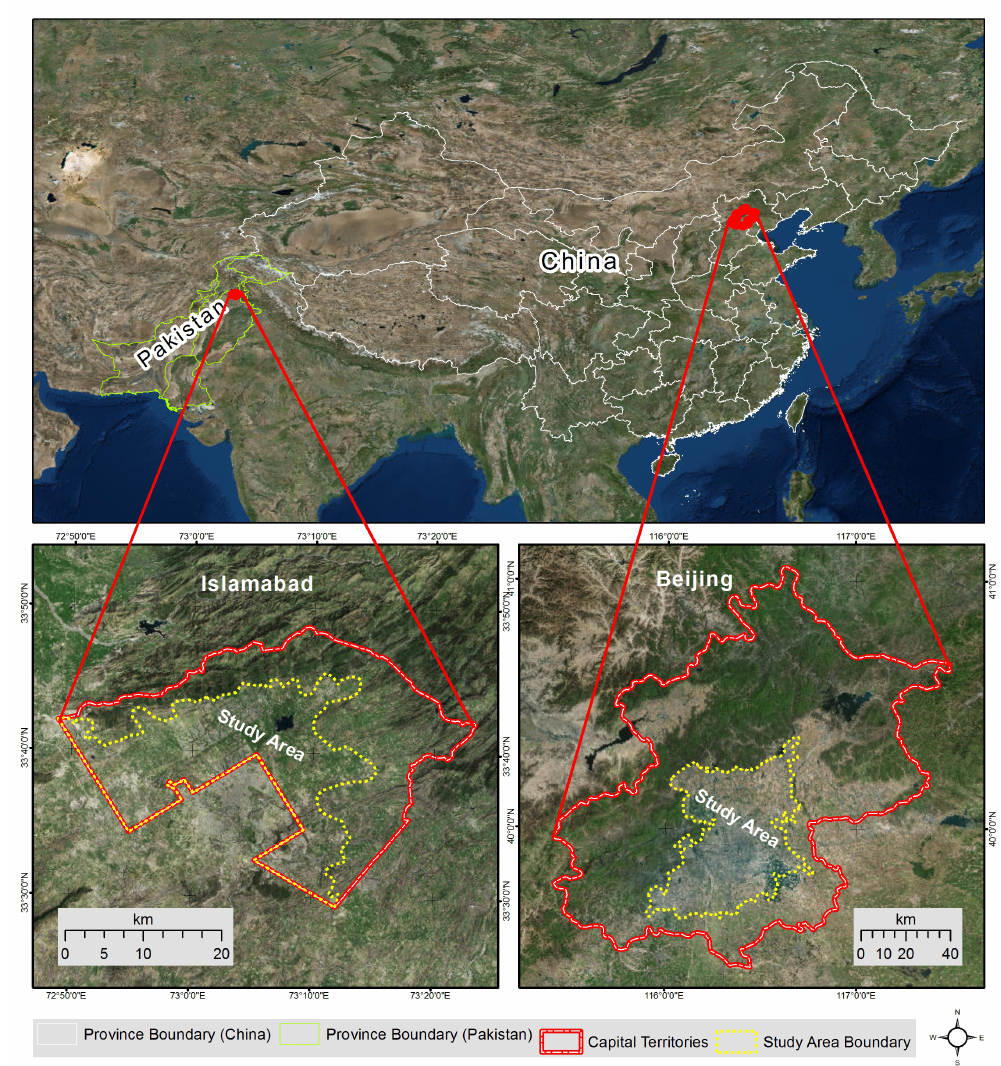
Figure 1. Location map of study